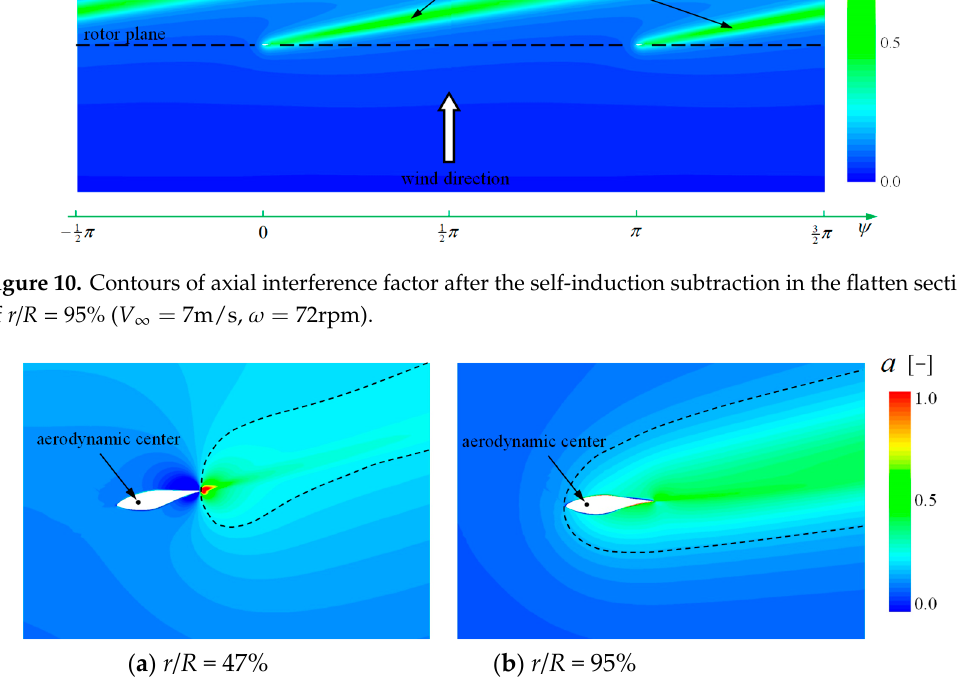
the dashed black line is a typical contour line ( 7m/s V ∞ = , 72rpm ω= ).